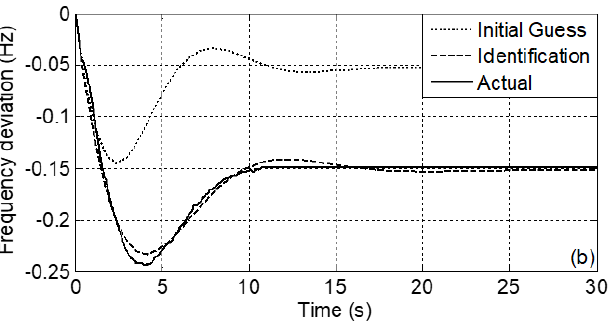
Figure 2. Comparison between the actual and identified systems. Reproduced from [15], IEEE: